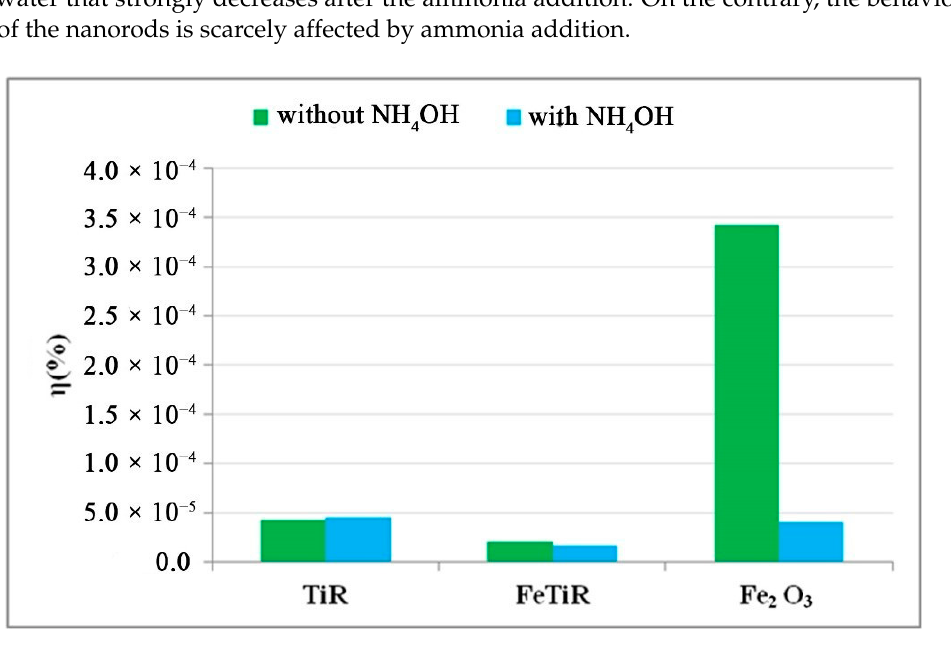
Figure 9. Comparative power conversion efficiency of the investigated samples measured in pure and ammonia containing electrolyte.